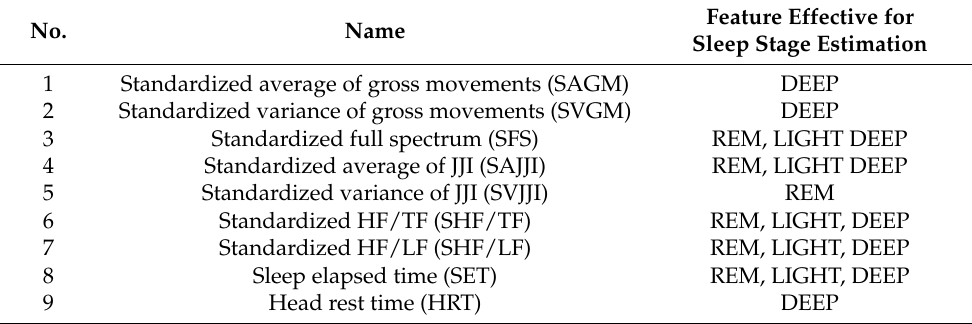
Table 3. Features used in the second-step